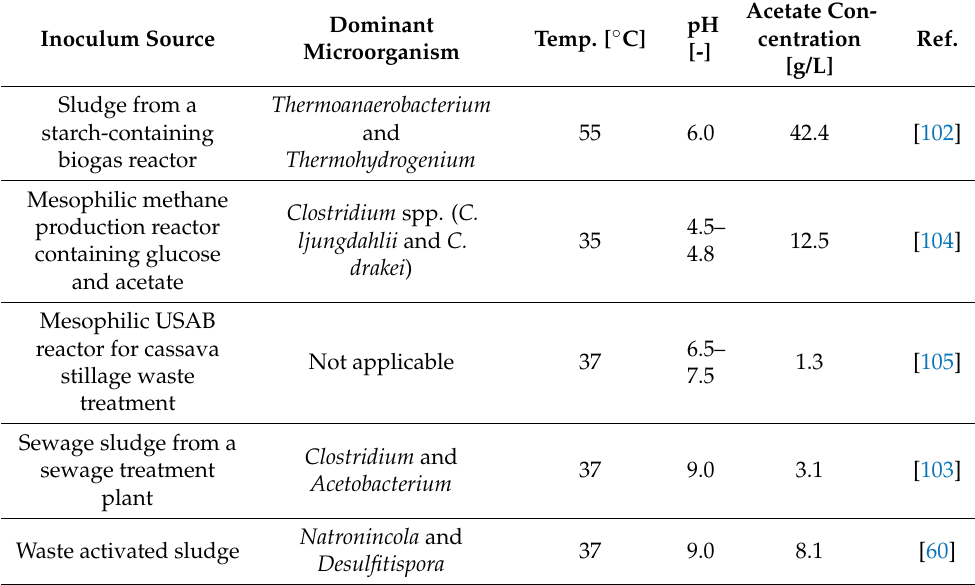
Table 4. Acetate production from syngas by mixed culture